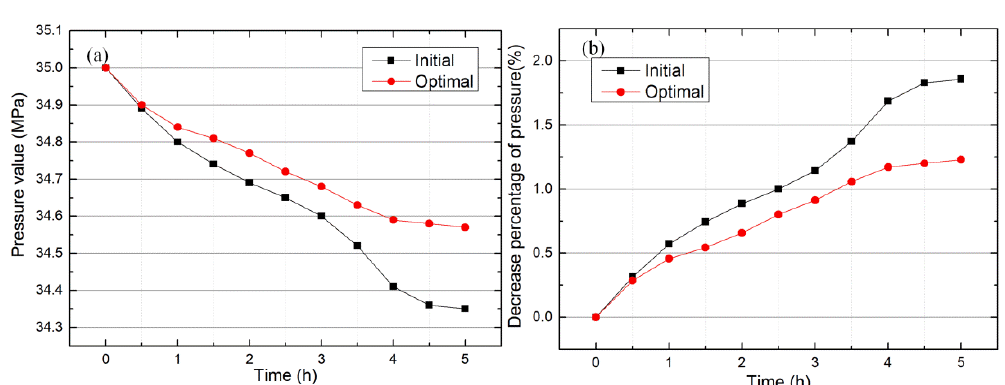
Figure 13. Curves of inner pressure of the connector prototype with the initial and optimal VX gasket: ( a ) change trend of the inner pressure value; and ( b ) decrease in percentage of the inner pressure.